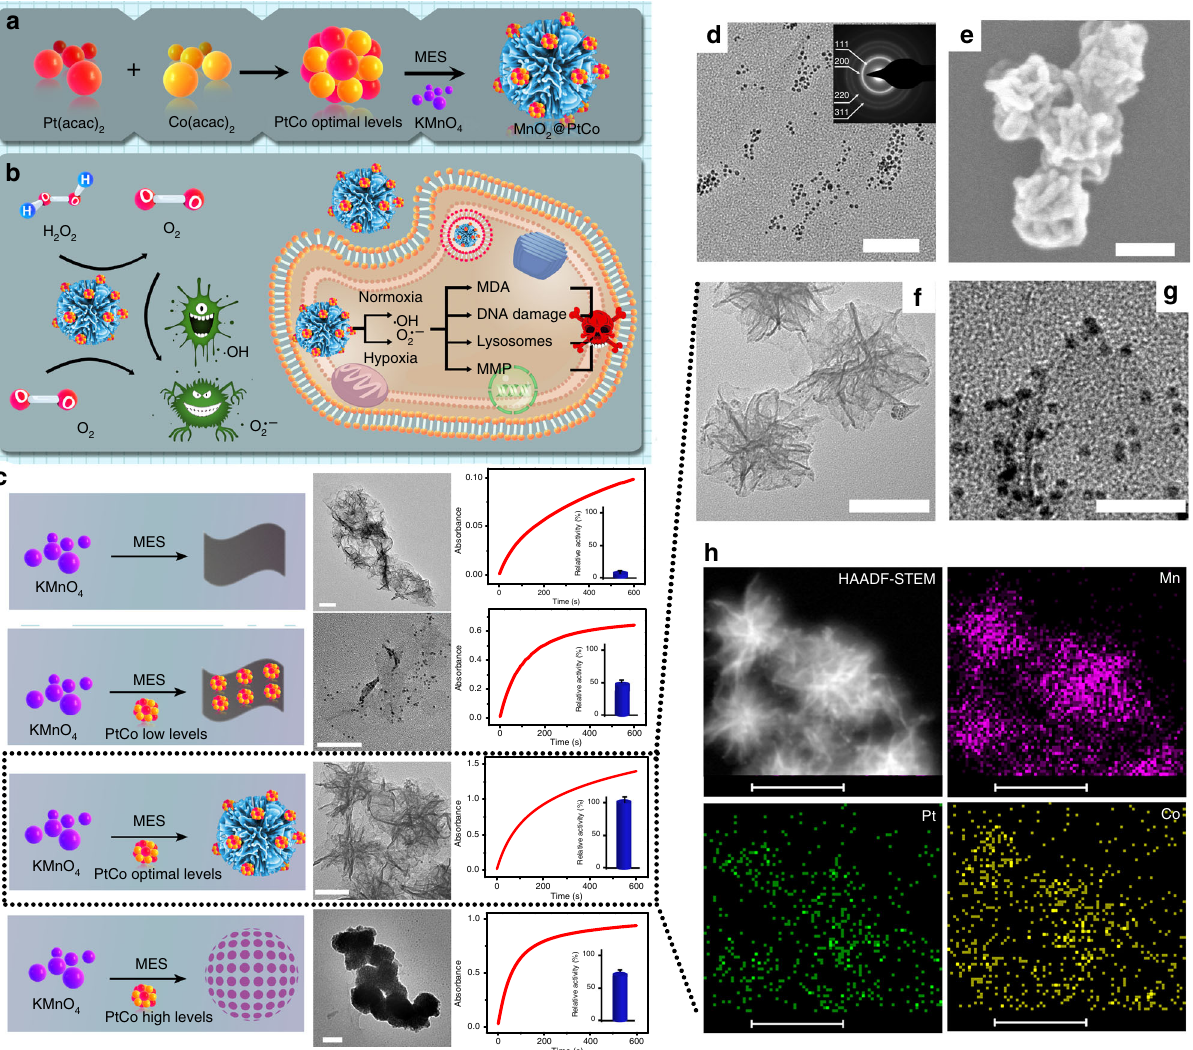
Fig. 1 Synthesis of MnO 2 @PtCo nano fl owers. a Schematic illustration showing the self-assembly of nanozymes into well-de fi ned nano fl owers. b Schematic representation of the generation mechanism of ROS and cytotoxicity by MnO 2 @PtCo nano fl owers under different oxygen tensions. c The in fl uence of PtCo concentration on the morphology and catalytic performance of MnO 2 @PtCo assemblies is directly suggested by TEM images and UV – vis analysis. In the lower concentration, PtCo nanoparticles could promote and stabilize MnO 2 crystal to form two-dimensional nanosheets. With increasing PtCo concentration, it could induce the self-assembly of MnO 2 @PtCo nanosheets to form nano fl ower. Nevertheless, further increasing the concentration of PtCo would lead to an increase in the level of self-assembly and therefore cause the formation of aggregated MnO 2 @PtCo nanospheres. Scale bars are 50 nm. Data were presented as mean ± s.d. ( n = 5). d TEM image of PtCo nanozymes (inset: SAED pattern). Scale bar is 50 nm. SEM ( e ) and TEM ( f ) image of MnO 2 @PtCo nano fl owers. Scale bars are 100 nm. g HRTEM image of MnO 2 @PtCo nano fl owers. Scale bar is 20 nm. h The high-angle annular dark- fi eld (HAADF)-STEM image of MnO 2 @PtCo nano fl owers, and corresponding TEM element mappings of the Mn K-edge, K-edge Pt, and Co K-edge signals.